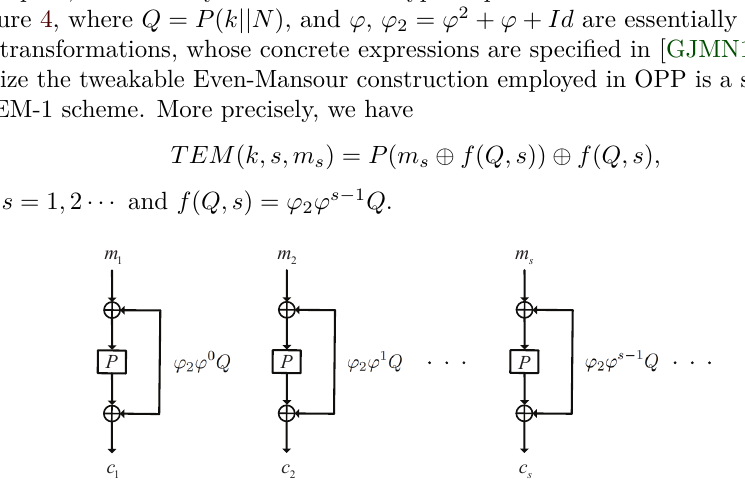
Figure 4: Encryption Procedure of OPP with Empty Associated